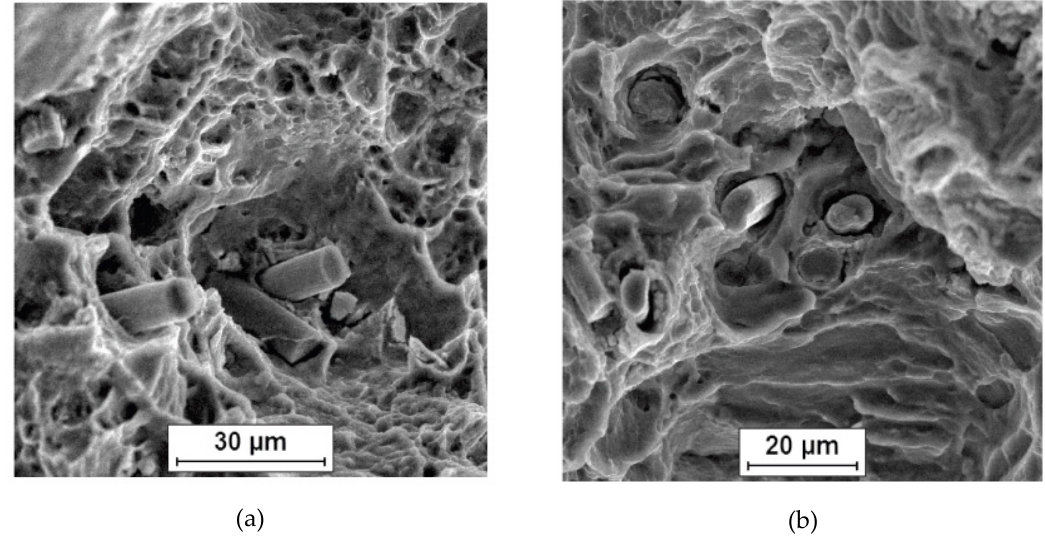
Figure 5. SEM micrographs of Mg-Csf composite fractures demonstrated differences in character of matrix decohesion: ( a ) KoBo-extruded, ( b ) hot-extruded.